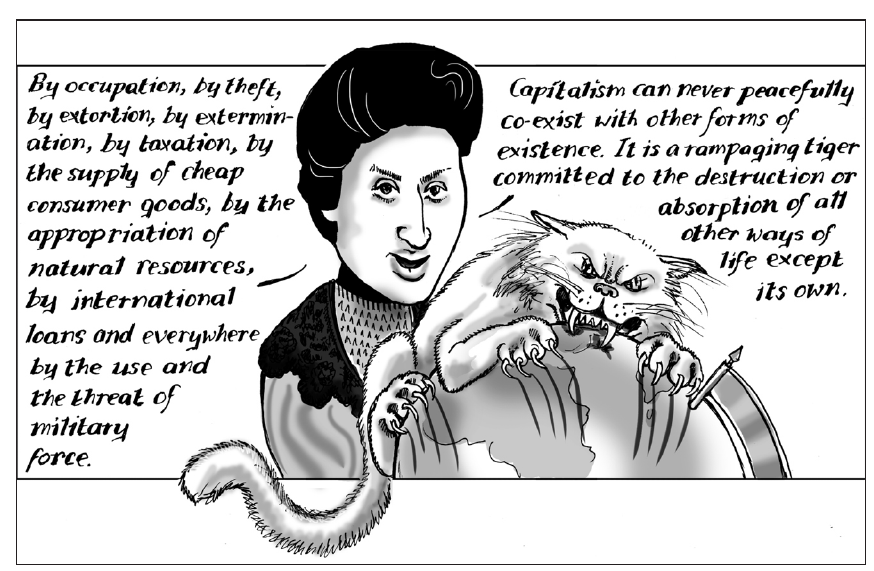
Figure 3: Excerpt from Evans, Kate (2015) Red Rosa: A Graphic Biography (London & New York: Verso) © Kate